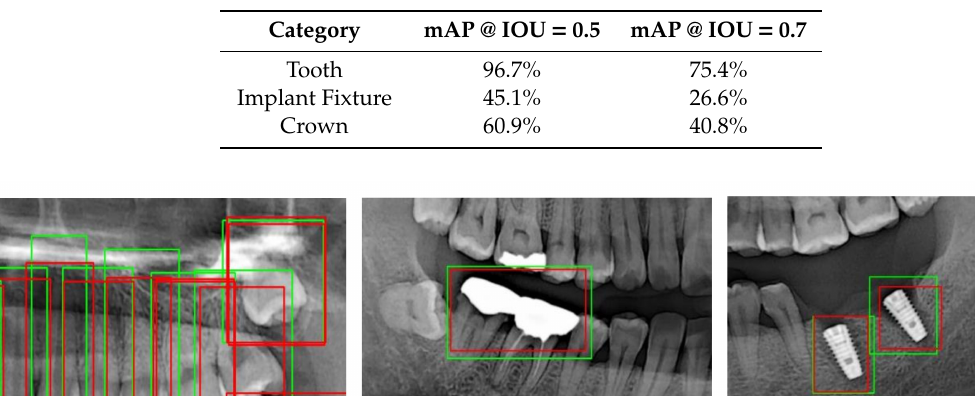
Table 2. Results of Dental Object Detection on AP@0.5, 0.7.